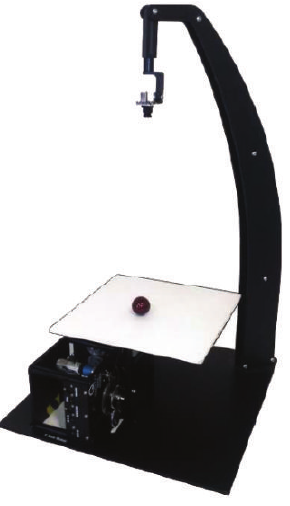
Figure 1: 2D Ball Balancer.